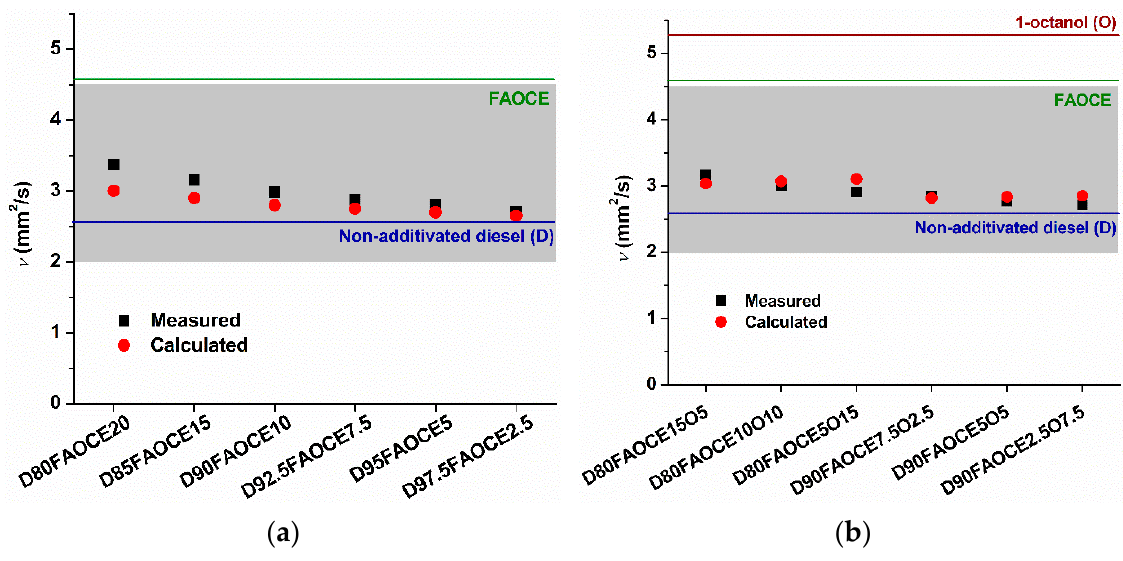
Figure 6. Comparison of measured and calculated kinematic viscosity values of binary ( a ) and ternary ( b ) blends of 80, 85, 90, 92.5, 95, and 97.5 vol% diesel.